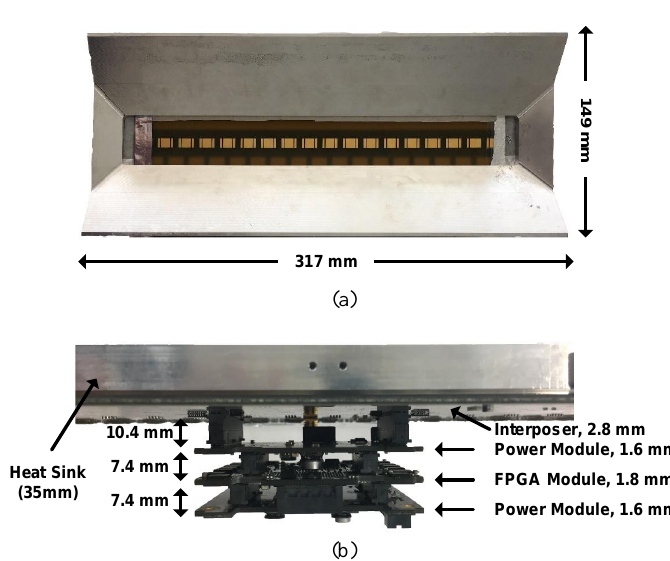
Figure 19. ( a ) Top view and ( b ) side view of a 1 × 16 subarray